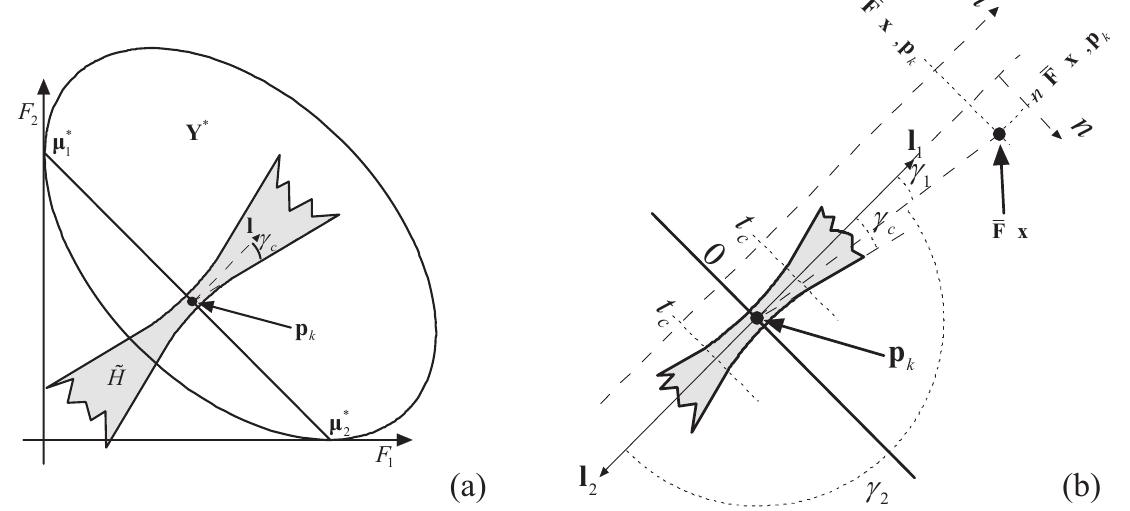
Fig. 8. DHCBI: a) problem formulation; b) detail of the DHCBI